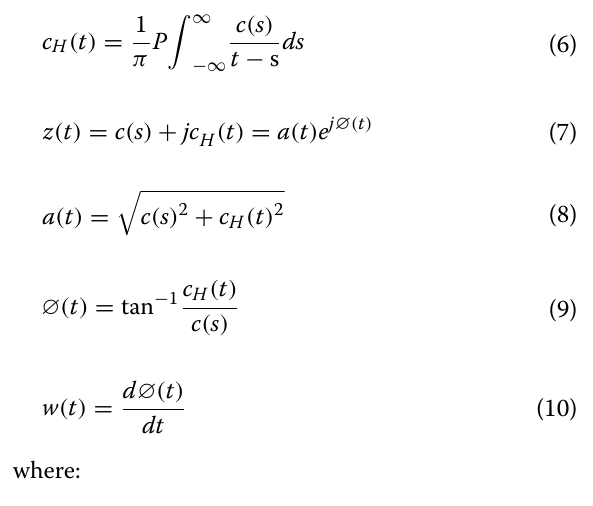
encourage reconstruction fidelity, typically in the pres- ence of additive Independent and Identically Distributed derived from an inversely proportional Bayesian prior to the noise level in the data. Lagrangian multipliers on constraints. Combining quadratic terms and Lagrangian multipliers results in nice convergence properties of the quadratic penalty at finite weight, and the strict